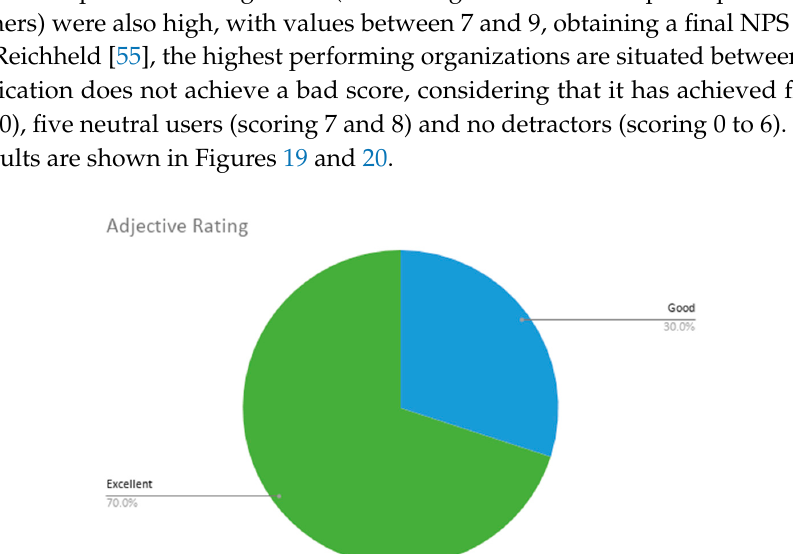
Figure 19. Adjective rating results. The pie chart with adjective ratings (possible options in improving value order: Worst Imaginable, Awful, Poor, OK, Good, Excellent, Best Imaginable); from the possible options, only Good and Excellent were used.